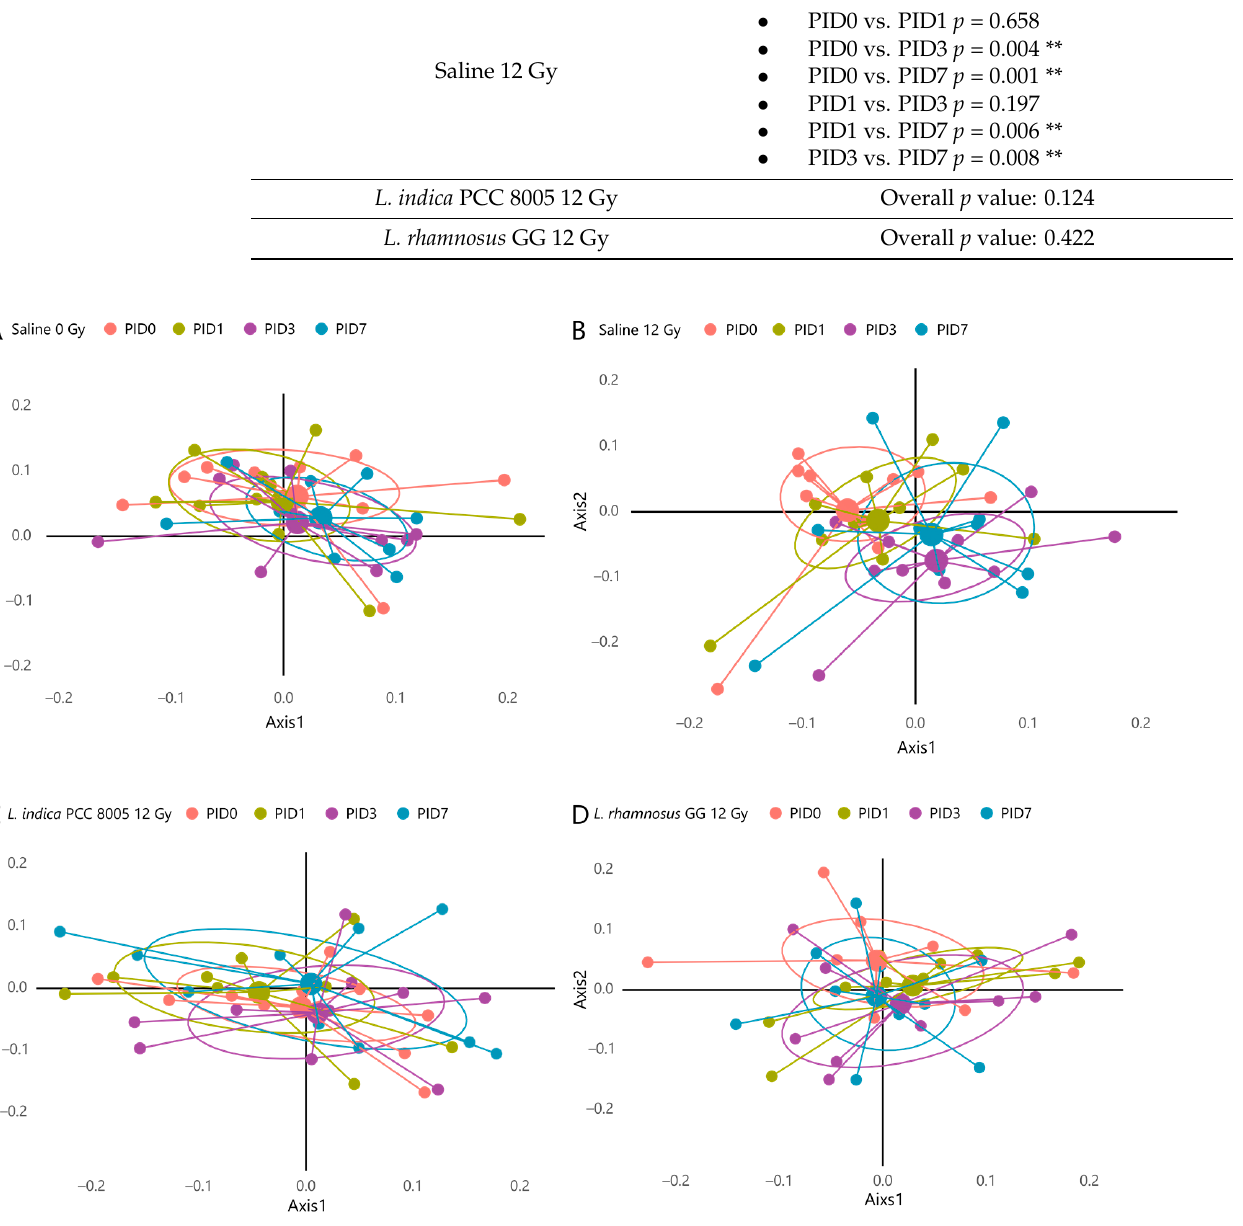
Figure 9. Unweighted UniFrac NMDS plots of ( A ) Saline 0 Gy-, ( B ) Saline 12 Gy-, ( C ) L. indica PCC 8005 12 Gy- and ( D ) L. rhamnosus GG 12 Gy-administered mice showing the beta diversity between samples, n ≥ 9 per group. PID = post-irradiation day. Table 1. p values (** p <0.01) of paired unweighted UniFrac beta diversity analyses by AMOVA. PID = post-irradiation day.